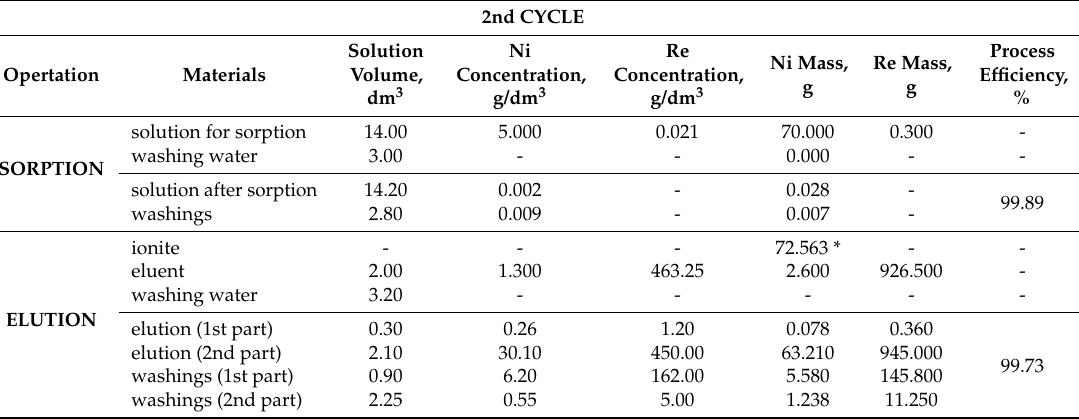
Table 16. Balance for nickel(II) sorption and elution—2nd cycle.